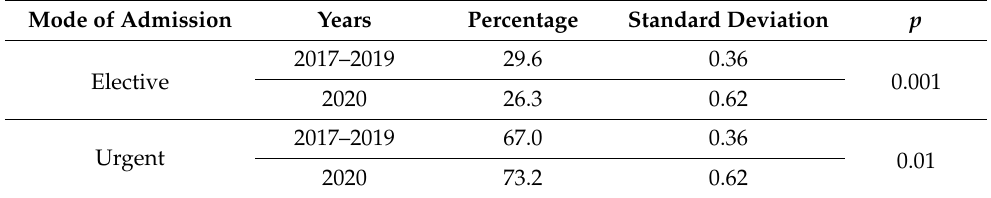
Figure 1. The number of DFU-related hospitalizations in Poland (2017–2019 (combined and averaged data), COVID = 0 vs. 2020, COVID = 1; 14,382.7 vs. 13,375, p = 0.17). Table 2. The percentage of urgent and elective admissions of patients with DFU or procedures associated with DFU (2017–2019 (combined and averaged data) vs. 2020).